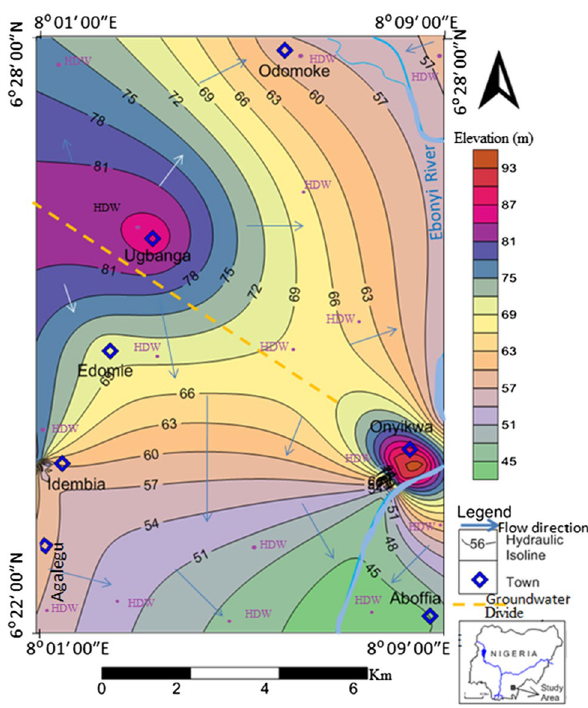
Fig. 6 Map showing hydraulic heads, groundwater flow directions/ divide (raw data in